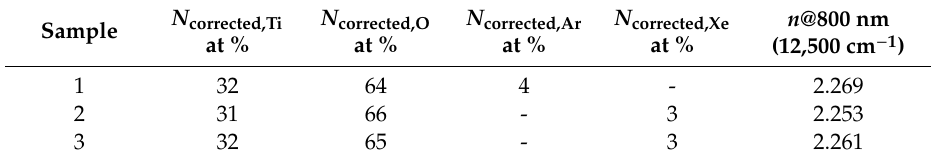
Figure 5. Modeled (solid line) and measured transmittance (up triangles) and reflectance (down triangles) at 60° for s- ( top left ) and p-polarizations ( top right ) and at near-normal incidence ( bottom left ) for sample 3 and modeled optical constants ( bottom right , refractive index: solid line, left axes; extinction coefficient: dotted line, right axes). Table 4. Here, beta-distributed oscillator (ß_do) parameters of all samples obtained from the spectra Table 5. Energy-dispersive X-ray spectroscopy (EDX) results and linear refractive index of the fitting. PIAD